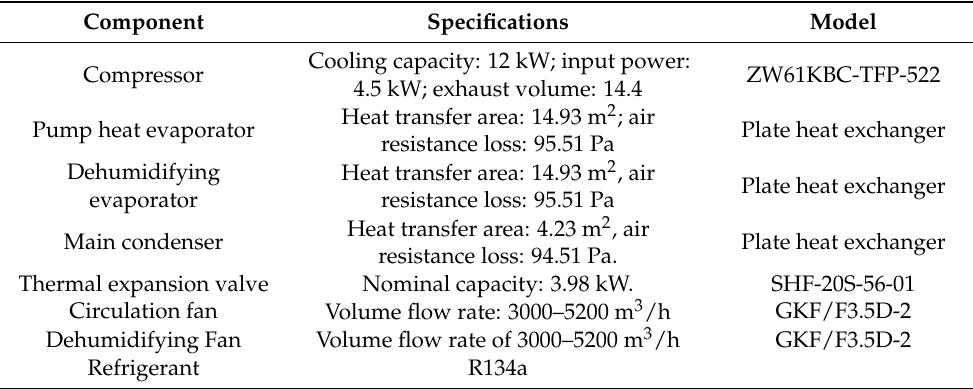
Figure 1. Schematic of the proposed SHPD. Table 1. Technical specifications of the equipment.